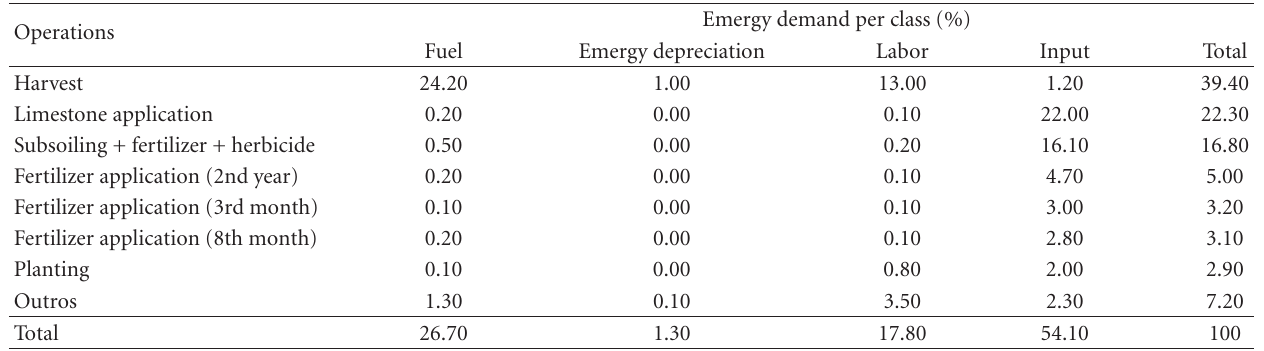
Table 3: Percentage of purchased emergy inputs ( F ) per operations and classes ∗ .